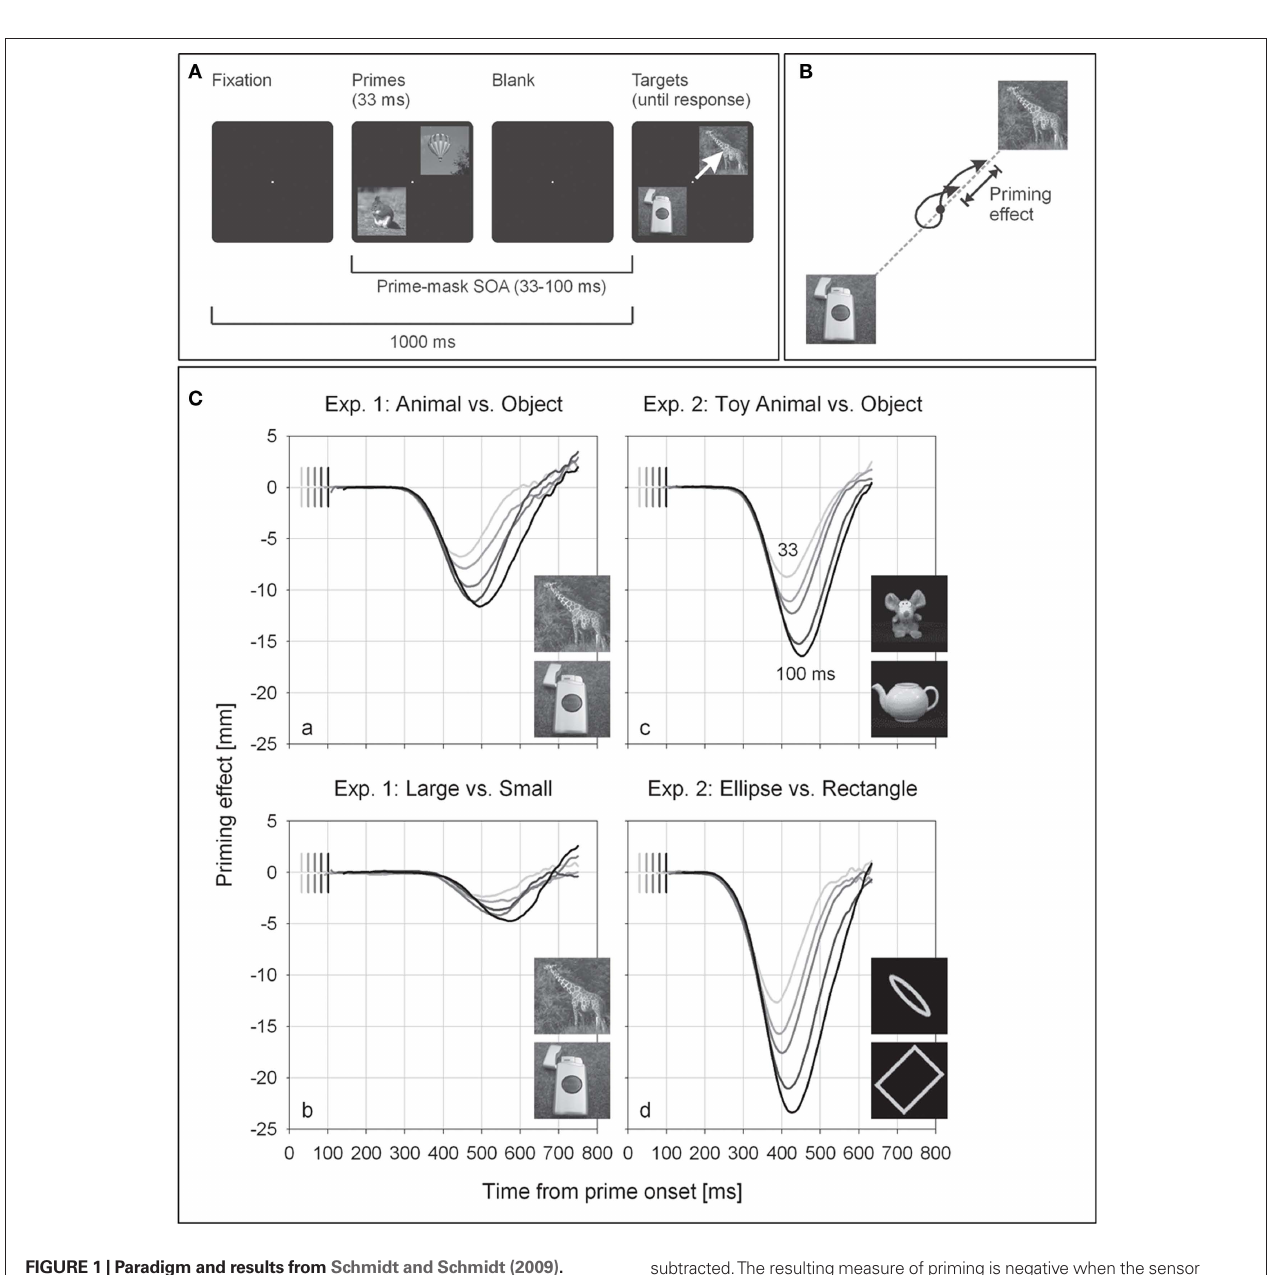
subtracted. The resulting measure of priming is negative when the sensor position in consistent trials leads the sensor position in inconsistent trials. (C) Spatial priming functions. Only correct responses are shown; functions are locked to prime onset. Reproduced with permission from